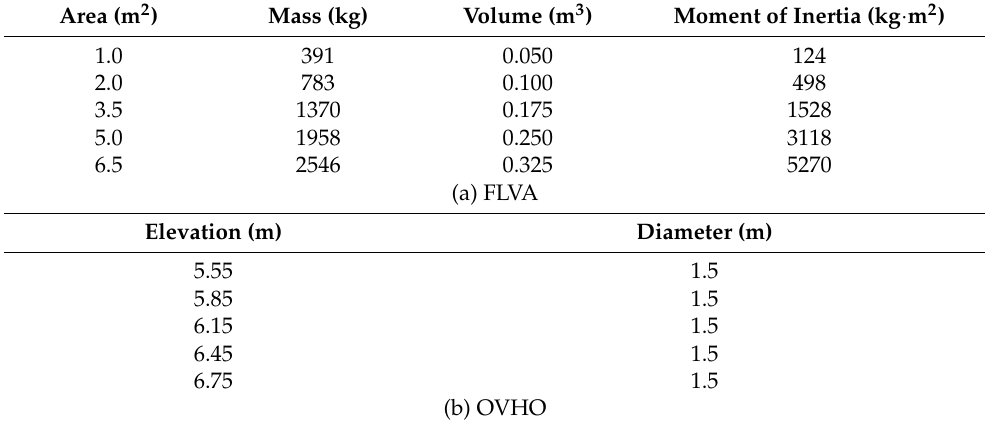
Table 1. The detailed dimensional parameters of OVHO and